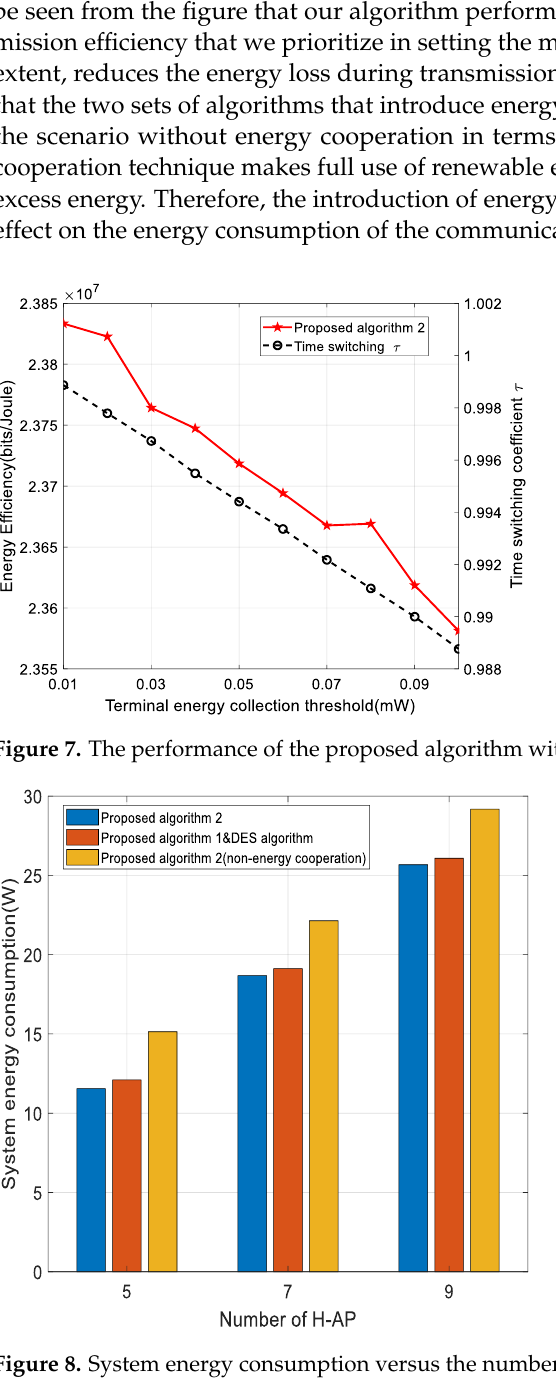
Figure 9. Terminal collects energy versus the number of terminals for different algorithms.